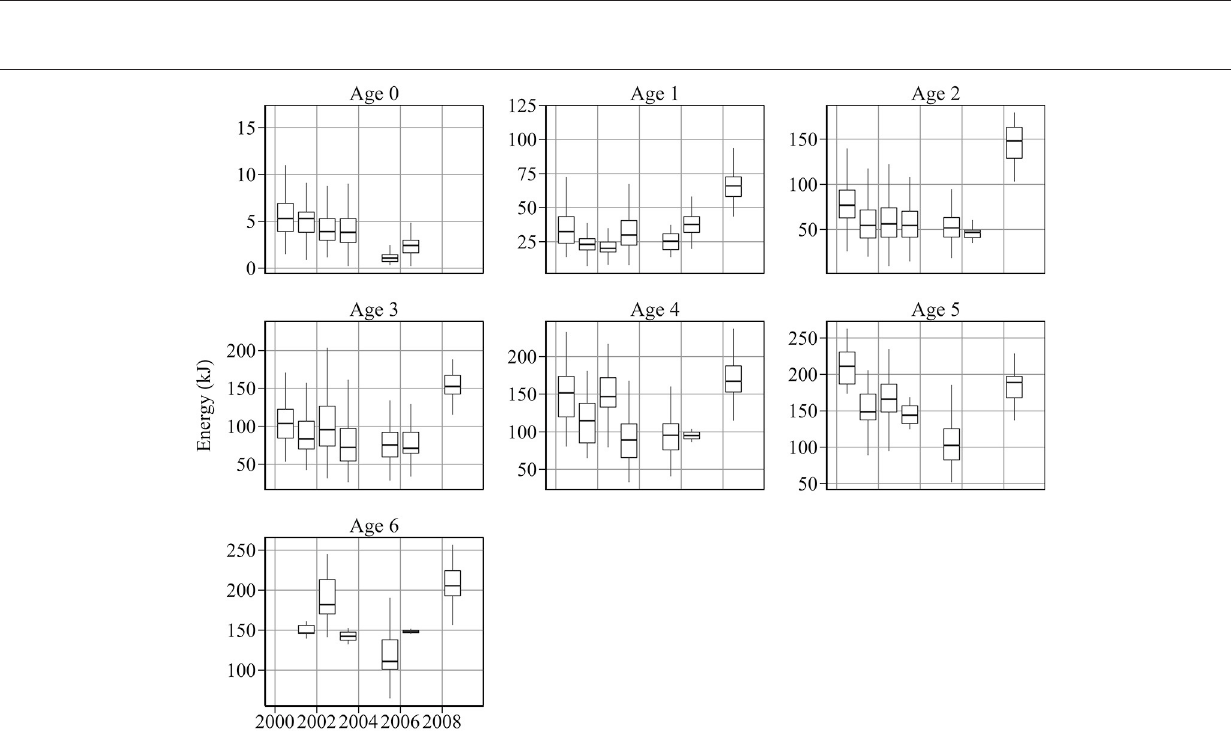
Frontiers in Marine Science |